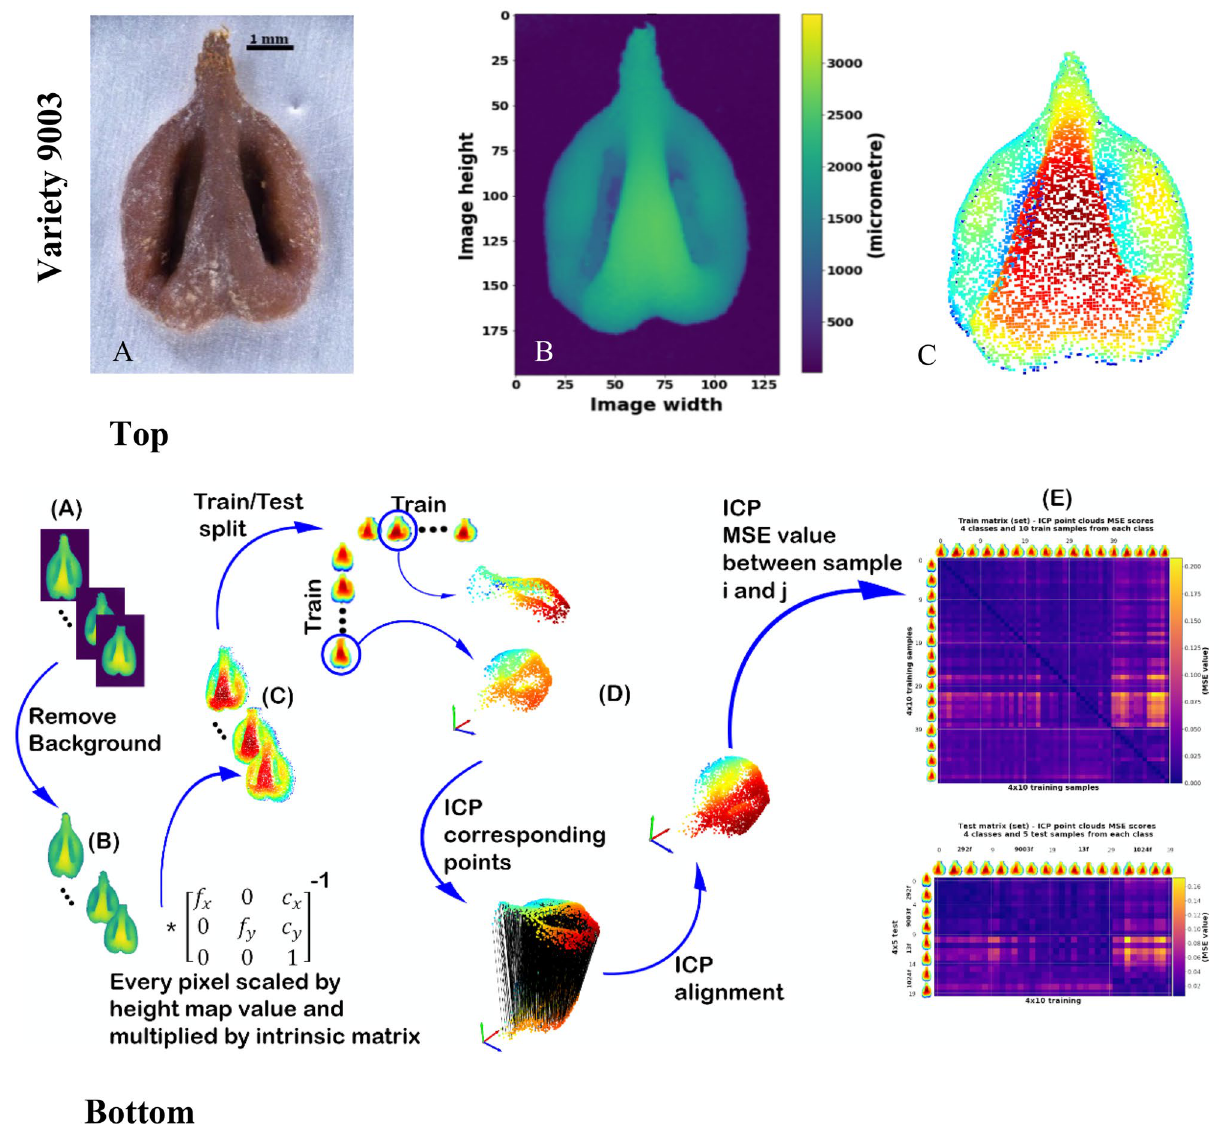
Figure 1. The procedure used for grape pip 3D data acquisition and Train and Test matrix preparation for LDA. ( A ) (Top)—high-quality focused image of grape pip; ( B ) (Top, Bottom)—height map image scan, and ( C ) (Top, Bottom)—3D points cloud representation of fresh pips of variety 9003 (Israeli endogenous variety). ( D ) (Bottom)—Process of applying ICP algorithm to discriminate between two sets of 3D points clouds samples. ( E ) (Bottom)—Training and Test matrices capturing the MSE between two points clouds sets, and serves as input for